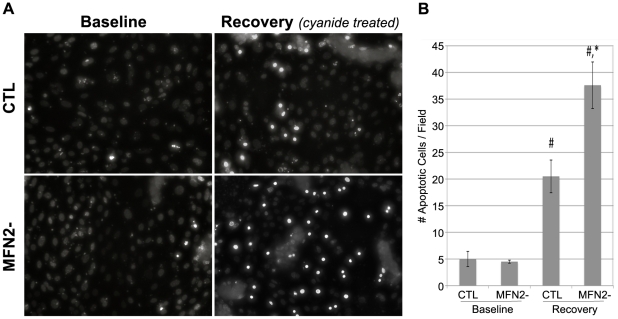
Effect of MFN2 deficiency on apoptosis after metabolic stress.(A) Wide field fluorescent microscopy of Cre (MFN2-) and empty (CTL) adenovirus transduced cells stained with Hoechst dye after 3 hr ATP depletion induced by cyanide exposure in glucose free medium followed by and 6 hr recovery in complete medium; apoptotic cells are brightly stained, small and round. (B) Quantitative analysis of apoptotic cell number in five randomly selected fields under each experimental condition; #
P<0.05 vs. EV/Base or CRE/Base, respectively; * P<0.05 vs. EV/Rec. Data represent the mean and SE of at least 3 separate experiments.